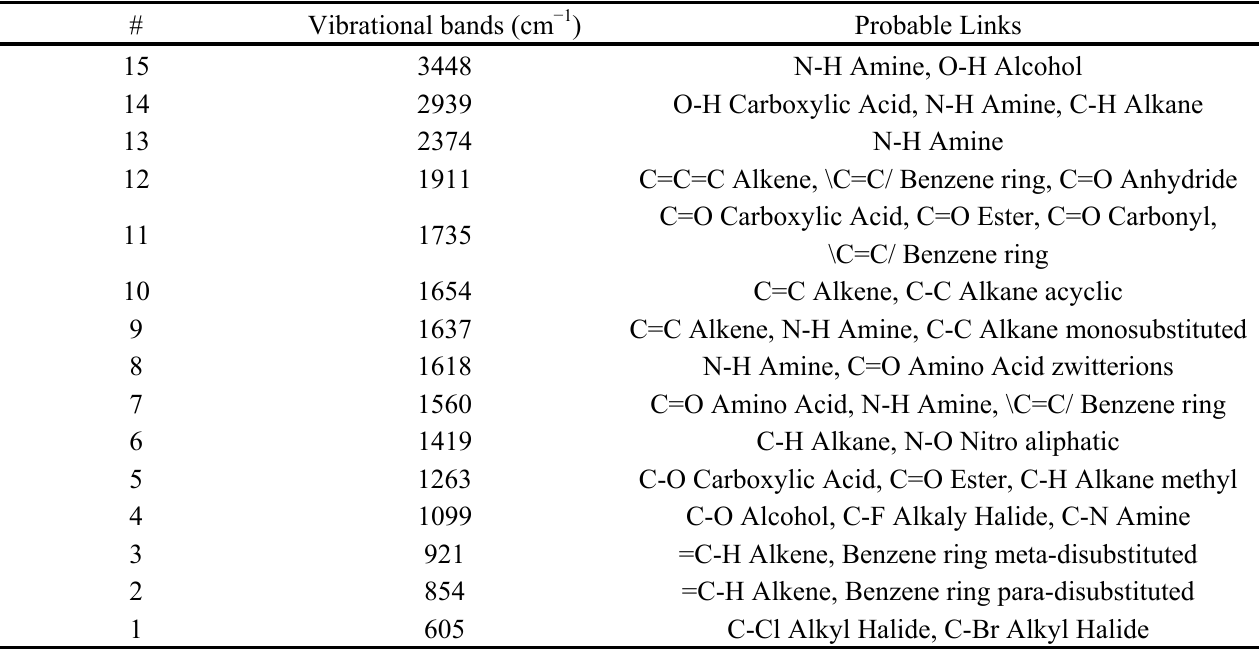
Table 3. Organic elements produced by the fermentation of chlorophyll and mucilage, which were detected by their specific vibrational